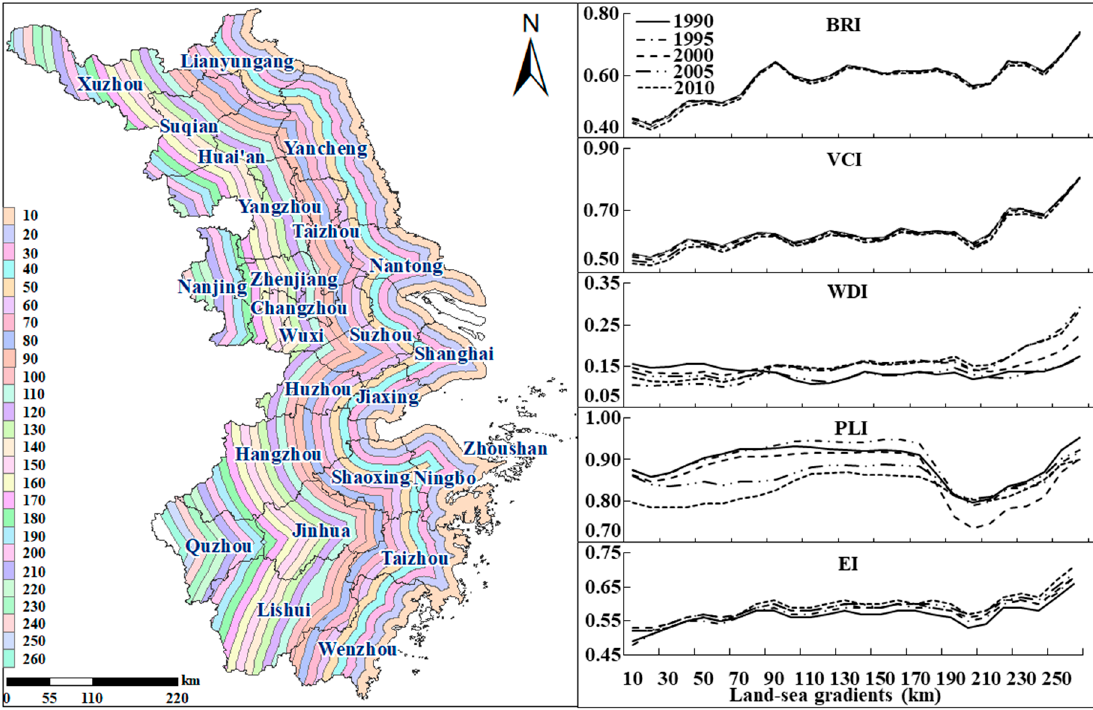
Figure 5. The influence of the distances to coastline on Eco_C in the YRD from 1990 to 2010.